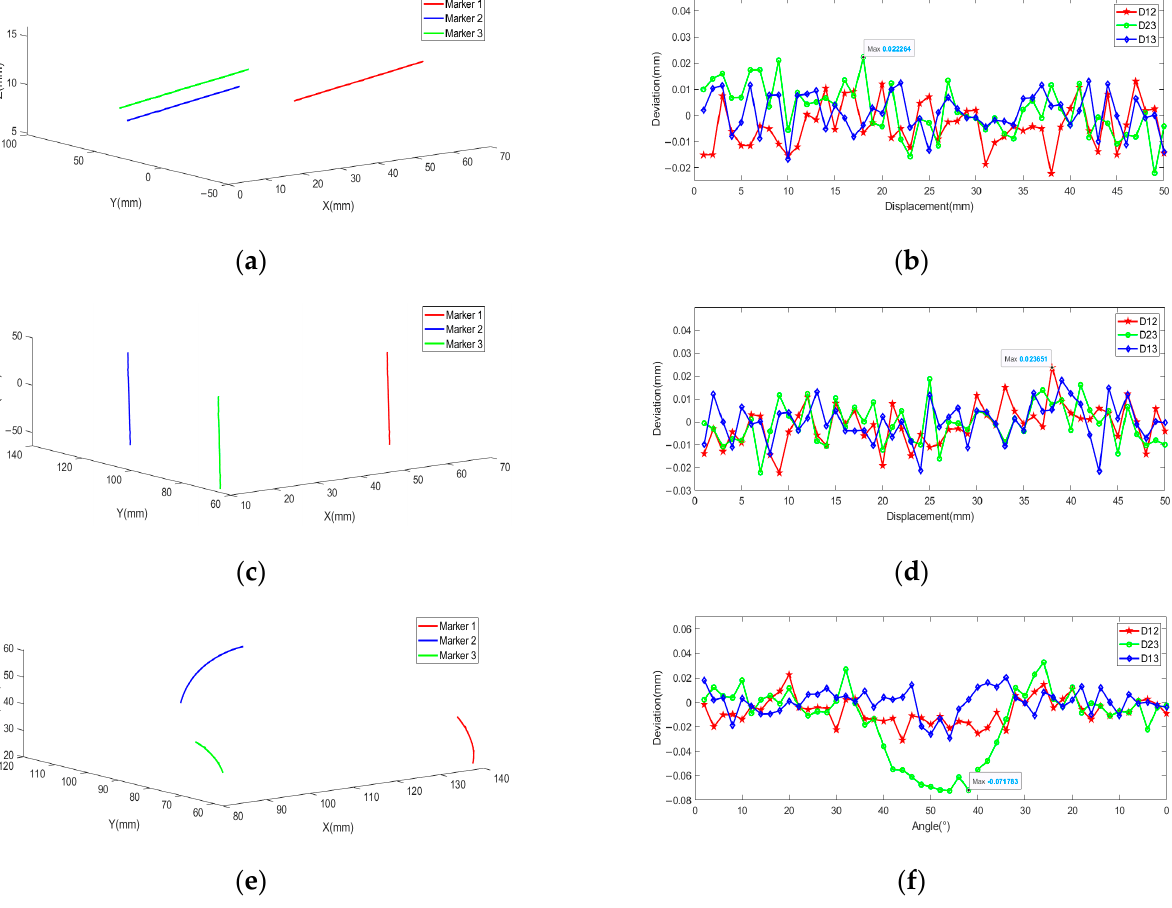
Figure 12. Track and deviation charts at different positions and angles. ( a ) Track of movement along the X axis. ( b ) Deviation of movement along the X axis. ( c ) Track of movement deviation along the Z axis. ( d ) Deviation of movement along the Z axis. ( e ) Track of rotation along the Y axis. ( f ) Deviation rotation along the Y axis.